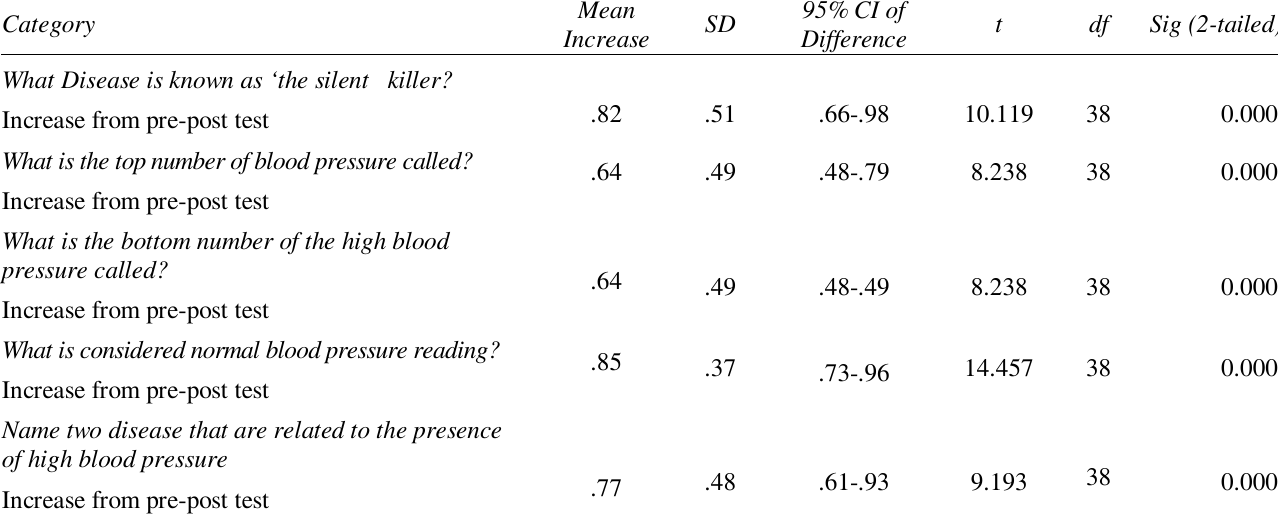
Table 2: Proportion increase in knowledge among students from pre-test to post-test